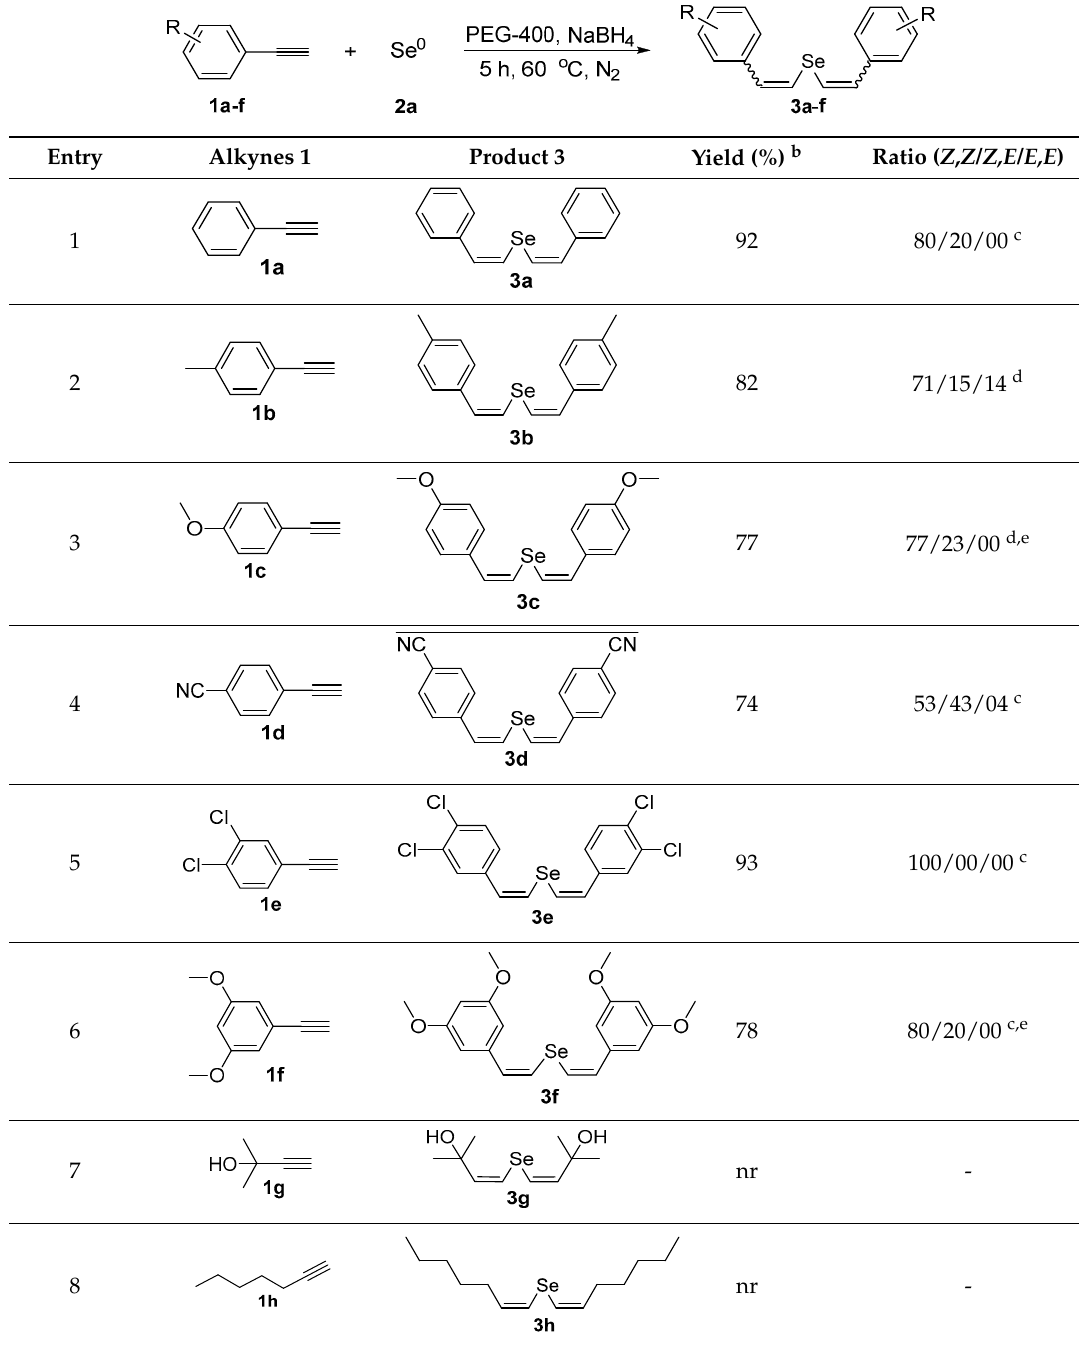
Molecules 2017 , 22 , 327 4 of 10 Table 2. Synthesis of divinyl selenides 3 by the hydroselenation of aryl alkynes 1 a . Table 2. Synthesis of divinyl selenides 3 by the hydroselenation of aryl alkynes 1 a . Table 2. Synthesis of divinyl selenides 3 by the hydroselenation of aryl alkynes 1 a . Table 2. Synthesis of divinyl selenides 3 by the hydroselenation of aryl alkynes 1 a . Table 2. Synthesis of divinyl selenides 3 by the hydroselenation of aryl alkynes 1 a . Table 2. Synthesis of divinyl selenides 3 by the hydroselenation of aryl alkynes 1 a . Table 2. Synthesis of divinyl selenides 3 by the hydroselenation of aryl alkynes 1 a . Table 2. Synthesis of divinyl selenides 3 by the hydroselenation of aryl alkynes 1 a . Table 2. Synthesis of divinyl selenides 3 by the hydroselenation of aryl alkynes 1 a . Table 2. Synthesis of divinyl selenides 3 by the hydroselenation of aryl alkynes 1 a . Table 2. Synthesis of divinyl selenides 3 by the hydroselenation of aryl alkynes 1 a . Table 2. Synthesis of divinyl selenides 3 by the hydroselenation of aryl alkynes 1 a . Table 2. Synthesis of divinyl selenides 3 by the hydroselenation of aryl alkynes 1 a . Table 2. Synthesis of divinyl selenides 3 by the hydroselenation of aryl alkynes 1 a . Table 2. Synthesis of divinyl selenides 3 by the hydroselenation of aryl alkynes 1 a . Table 2. Synthesis of divinyl selenides 3 by the hydroselenation of aryl alkynes 1 a . Table 2. Synthesis of divinyl selenides 3 by the hydroselenation of aryl alkynes 1 a . Table 2. Synthesis of divinyl selenides 3 by the hydroselenation of aryl alkynes 1 a